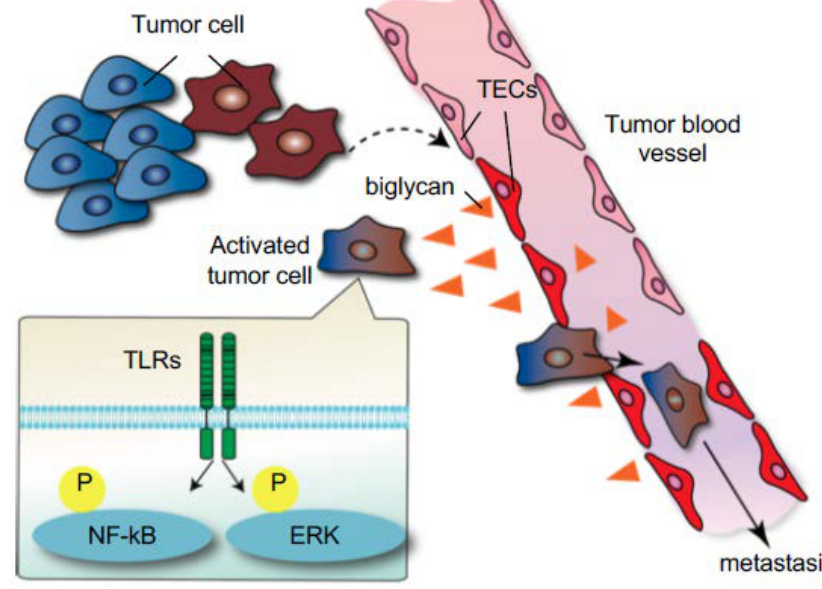
Figure 4. Induction of tumor metastasis by tumor endothelial cells TECs through biglycan secretion. The interaction between tumor cells and the microenvironment alters TEC phenotypes (dotted arrow). In turn, these altered TECs express high levels of biglycan, which induces tumor cells to metastasize through the activation of NF- κB and ERK signaling (black arrow) [73]. (Reprinted from Maishi et al., Sci. Rep. 2016 , with permission from Sci. Rep. ).